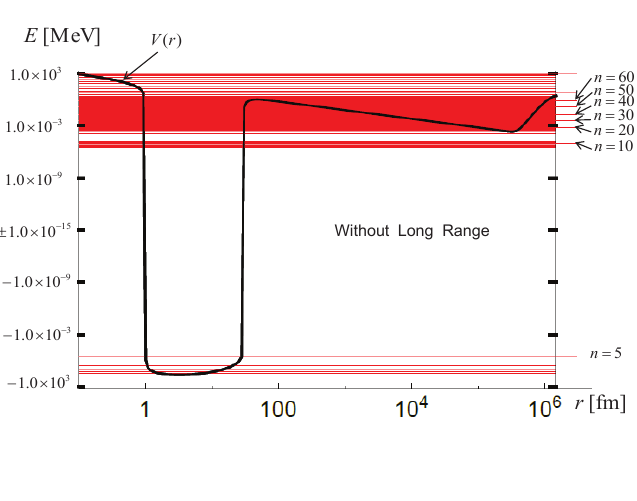
Figure 2: Energy levels and potential “without long range potential”. The attrac- tive potential part of the shorter range (fm region) indicates mainly the nuclear WS potential, and the next attractive part in the 10 5 fm region is the Coulomb attractive potential between the Cs ion and the Pd cage. n is the principal quantum number. 1 ≤ n ≤ 5 shows the La nuclear levels, and 6 ≤ n ≤ 60 states represent the molecular levels for CsD , 2